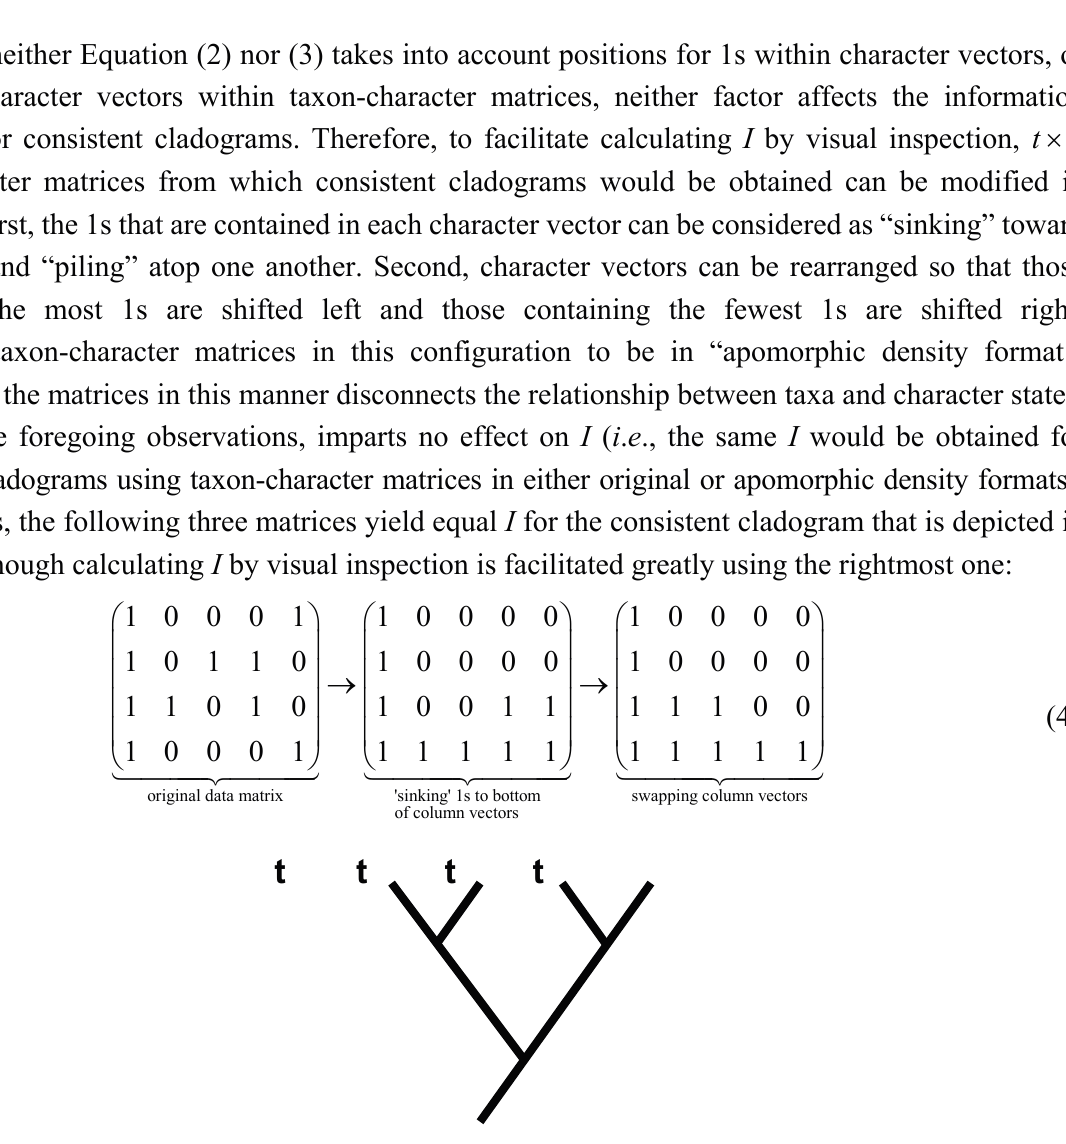
Figure 1. Consistent cladogram that would be obtained from cladistic analysis involving leftmost matrix (4); in that matrix, row i contains character states for taxon i and columns contain character